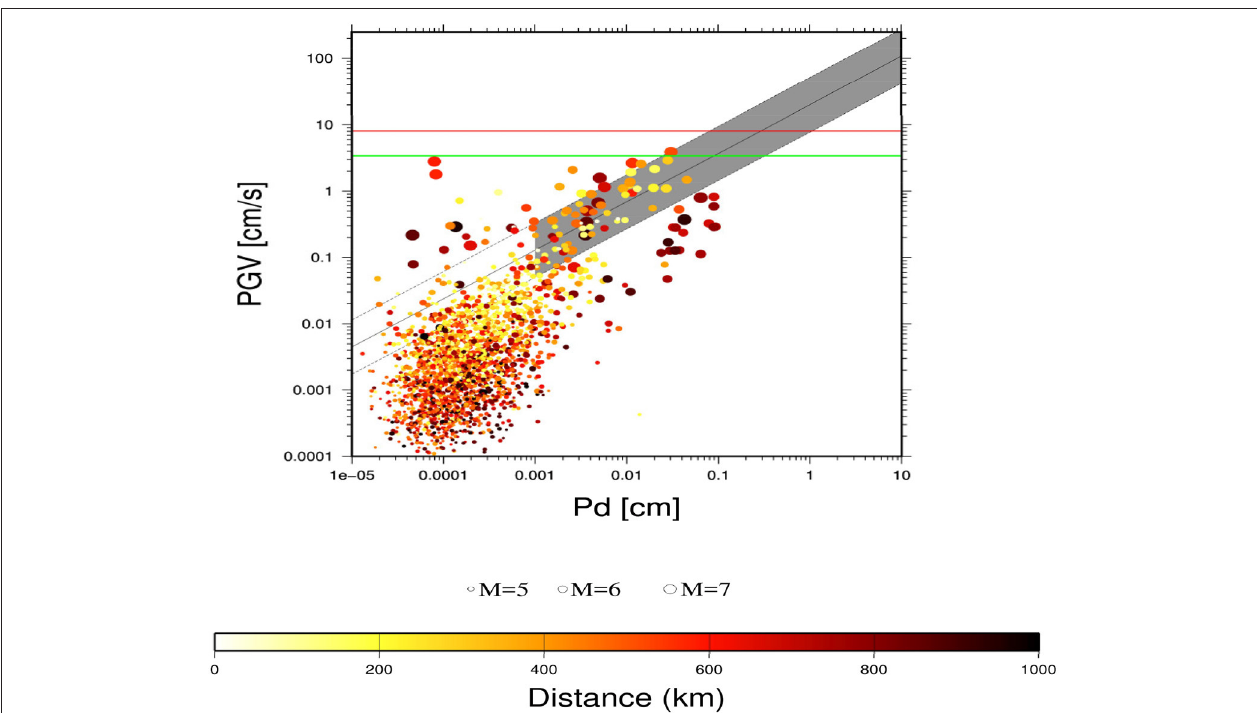
FIGURE 4 | The observed PGV of an event vs. the observed peak amplitude of vertical displacement Pd (circles) derived from the first 3s of recordings after the event trigger. The size of the symbols indicates the magnitude, while the color shows the hypocentral distance. The continuous and dashed gray lines denote the mean and the standard deviation of the Zollo et al. (2010) relationship. The gray shaded area indicates the range of PGV/Pd over which the relationship was calibrated. The horizontal green line indicates the threshold of PGV = 3.4 cm/s for which a GREEN status is expected ( no Alarm ), while the red line shows the values above which an Alarm (RED status) should be